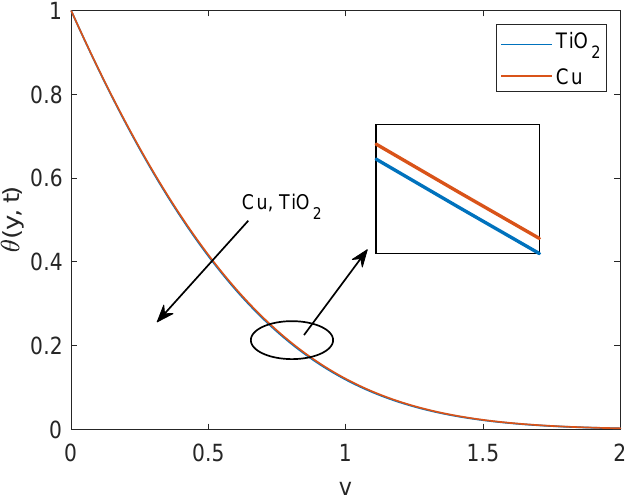
Figure 10. Temperature profile comparison for Cu-water and TiO 2 -water when Nr = 5, Q = 0.5, Pr = 6.2, φ = 0.1 and t = 0.5.